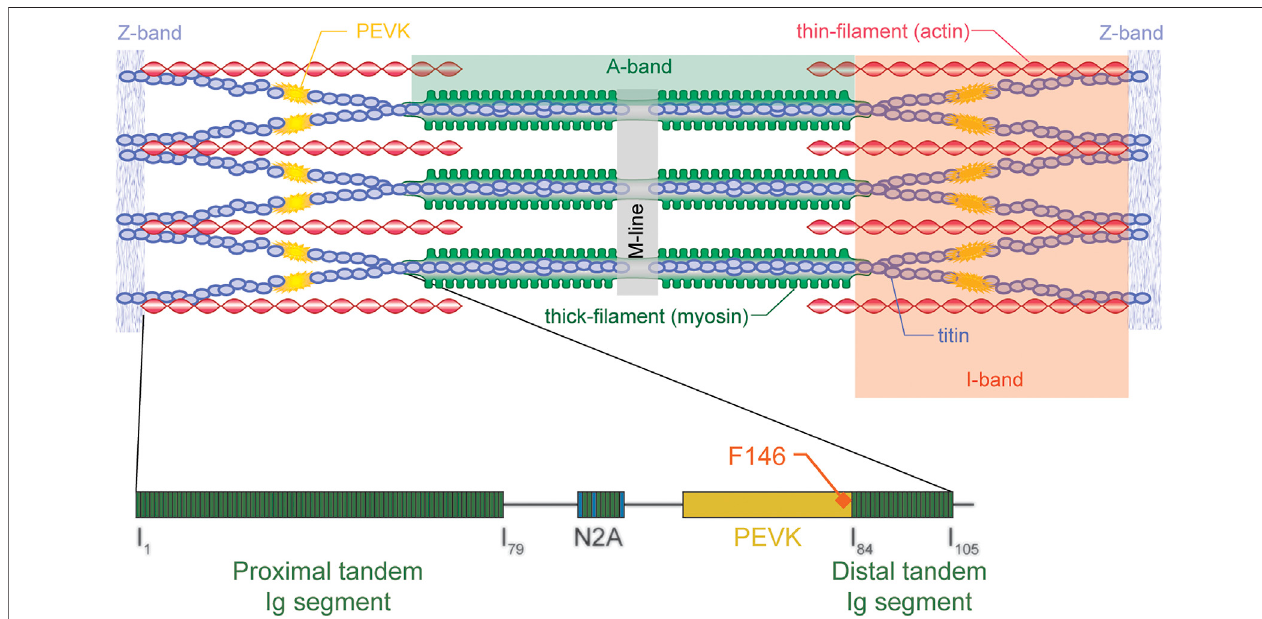
FIGURE5 | Schematic illustration of asarcomere (top) with actin, myosin, and titin (and titin ’ s molecular structure - bottom) indicated. Titin inserts into the M-line in the middle of the sarcomere and the Z-line at the end of the sarcomere, thus spanning the entire half-sarcomere. Titin is “ rigidly ” bound to the myosin fi lament in the A-band region but runs freely across most of the I-band region, except at the very proximal end where it merges with actin just prior to inserting into the Z-line. In the I-band region, titin elongates, thus producing passive force when a sarcomere is stretched. For physiologically relevant elongations of skeletal muscles, titin ’ s immunoglobulin become aligned and the PEVK segment elongates. Only towards the end of physiologically relevant elongations, or when the muscle is active (rather thanpassive)isitthoughtthatimmunoglobulin(Ig)domainsunfold.ShownisalsotheF146antibody(forfurtherdetailsseetextbelow)whichattachestothedistalendof thePEVKdomain oftitin.Republishedwithpermission ofJohn Wiley&Sons, Inc.,from Structure-functionrelations ofthegiant elastic protein titininstriatedandsmooth muscle cells. Granzier H, Labeit S. Muscle & Nerve Volume 36, p . 740 – 755. 2007; permission conveyed through Copyright Clearance Center